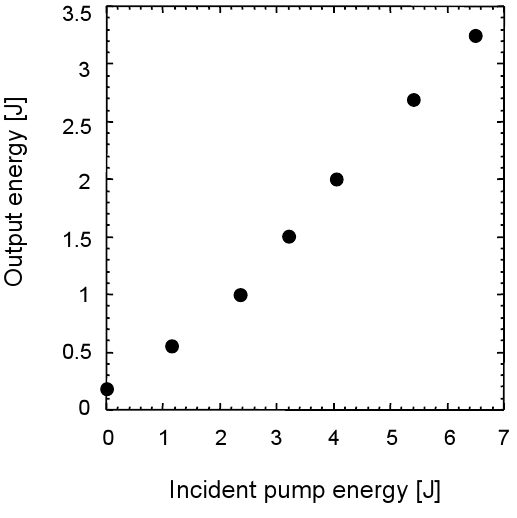
Figure 4. Measured output energy from Ti:sapphire power amplifier versus pump